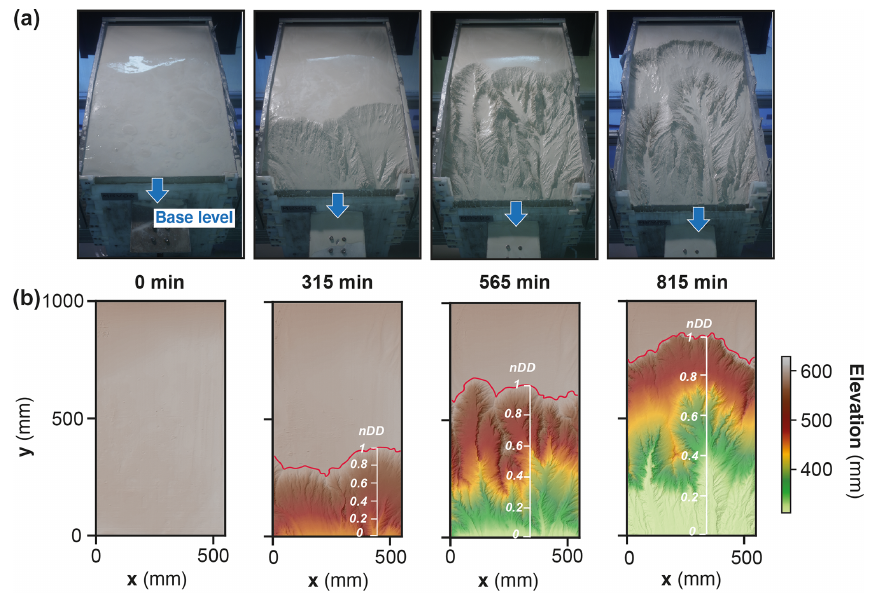
Figure 4. Photos (a) and corresponding DEMs (b) of experiment BL15 at four run times. Note the propagation of the divide (red line) through the erosion box and the drop of the sliding gate used for falling base level (blue arrows). The normalized distance to divide (nDD, see text) used to follow the position of knickpoints during runs is shown superimposed on DEMs.